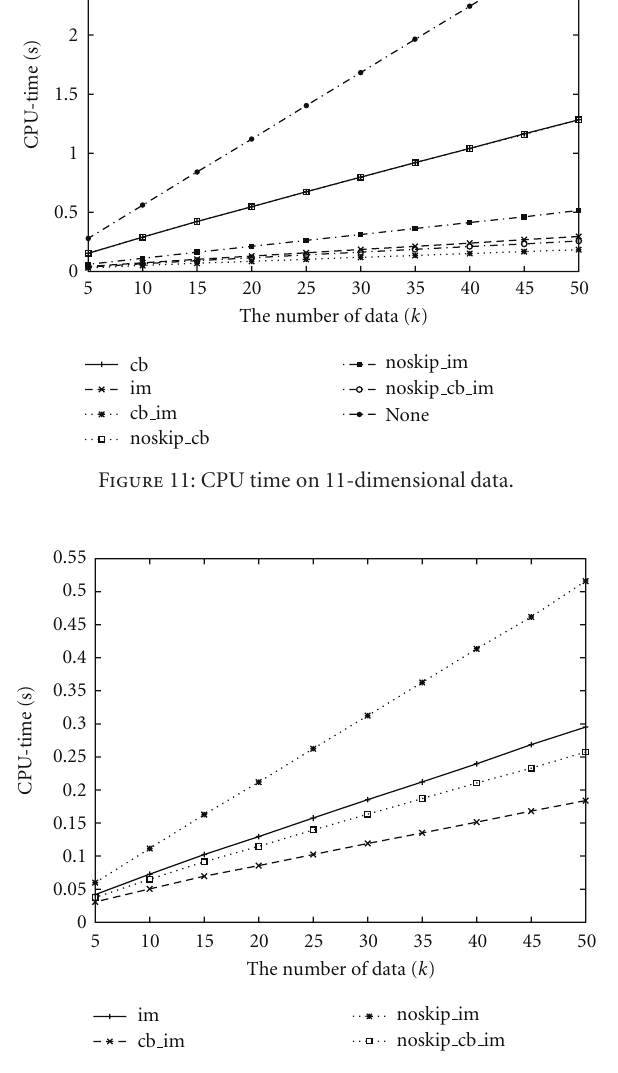
Figure 12: CPU time on 11-dimensional data (enlarged graph).